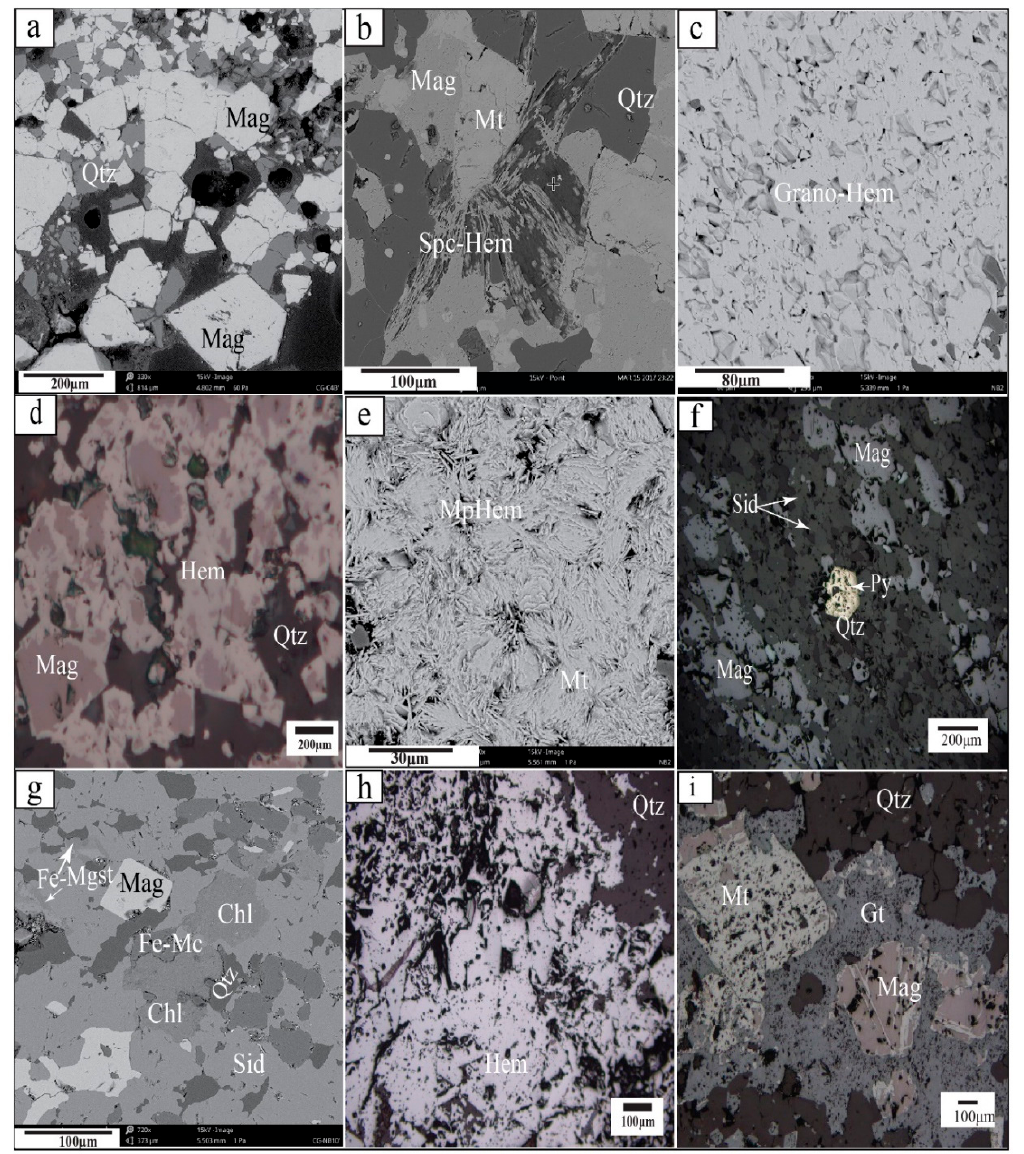
Figure 7. ( a ) Euhedral to subhedral magnetite (Mag) crystals (Backscatter Electron image), magnetite and quartz boundaries locally display 120 ◦ C triple junctions in hematite-enriched BIF; ( b ) photomicrograph displaying intergrowths of lamellar-grained specular hematite and crystalline quartz (Backscatter Electron image, stage HO-1); ( c ) granoblastic (metamorphic) recrystallization texture defined by hematite (stage HO-1; Backscatter Electron image); ( d ) high-grade iron ore showing hematite with magnetite relicts (reflected light); ( e ) microplaty hematite with distinct intergranular voids (likely caused by leached quartz or silicates) and local martite in high-grade hematite ore (Backscatter Electron image, stage HO-1); ( f ) photomicrograph showing large elongated magnetite grains forming magnetite bands orientated parallel to the banding of siderite and ferroan-magnesite, where pyrite occurs within it (reflected light, stage HO-2); ( g ) photomicrograph showing the assemblage of euhedral magnetite, chlorite, quartz, and ferro-microcline overgrowths. Siderite replaced by ferroan-magnesite (Backscatter Electron image, stage HO-2); ( h ) granular mass of hematite, high-grade iron ore (reflected light, stage HO-2); ( i ) martitization of magnetite along grain boundary with goethite (reflected light, supergene). Abbreviations: Chl, chlorite; Fe-Mc, ferro-microcline; Fe-Mgst, ferroan-magnesite; Fe-Ms, ferro-muscovite; Gt, goethite; grano-hem, granoblastic hematite; Hem, hematite; Mag, magnetite; Mt, martite; Mphem, microplaty hematite; Py, pyrite; Qtz, quartz; Sid, siderite; Spc hem, specularite hematite.